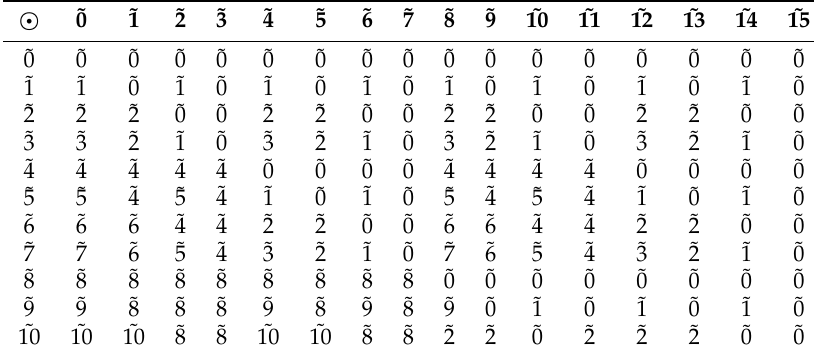
Table 2. Cayley table for the binary operation “ (cid:12)